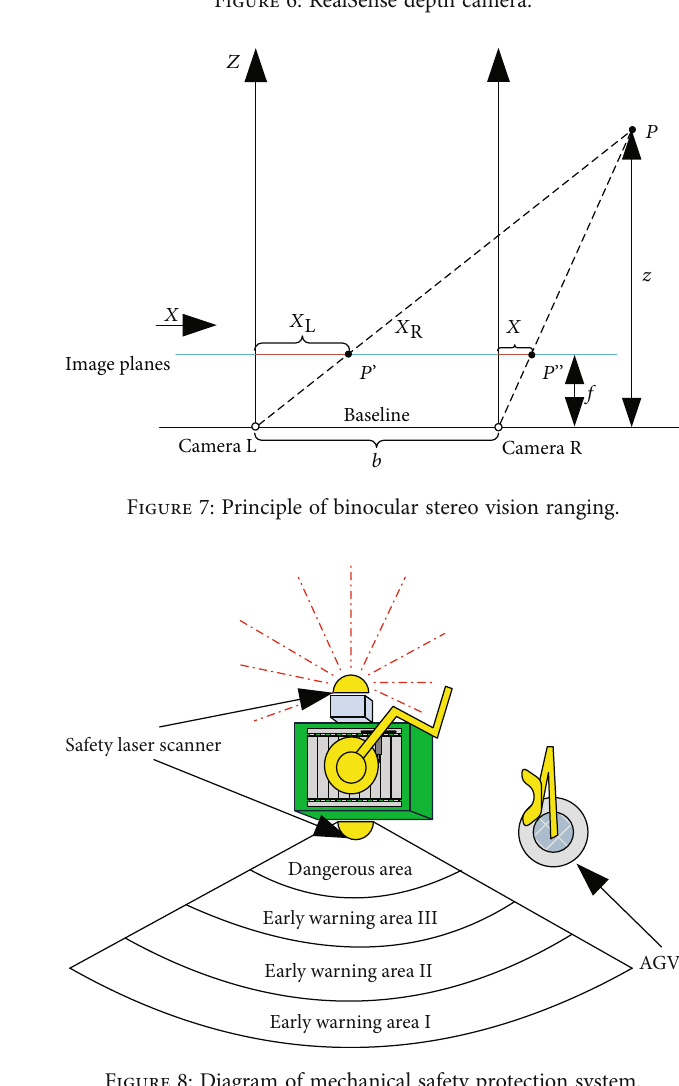
Figure 8: Diagram of mechanical safety protection